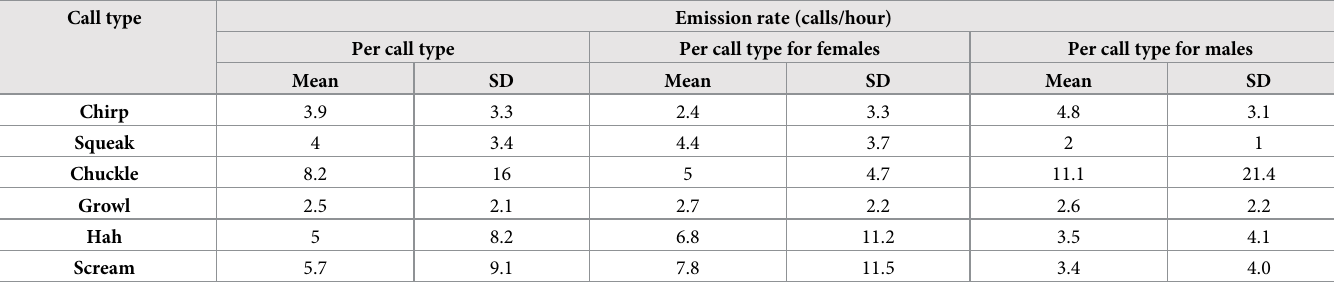
Table 2. Emission rate, mean and standard deviation (SD), per call type and